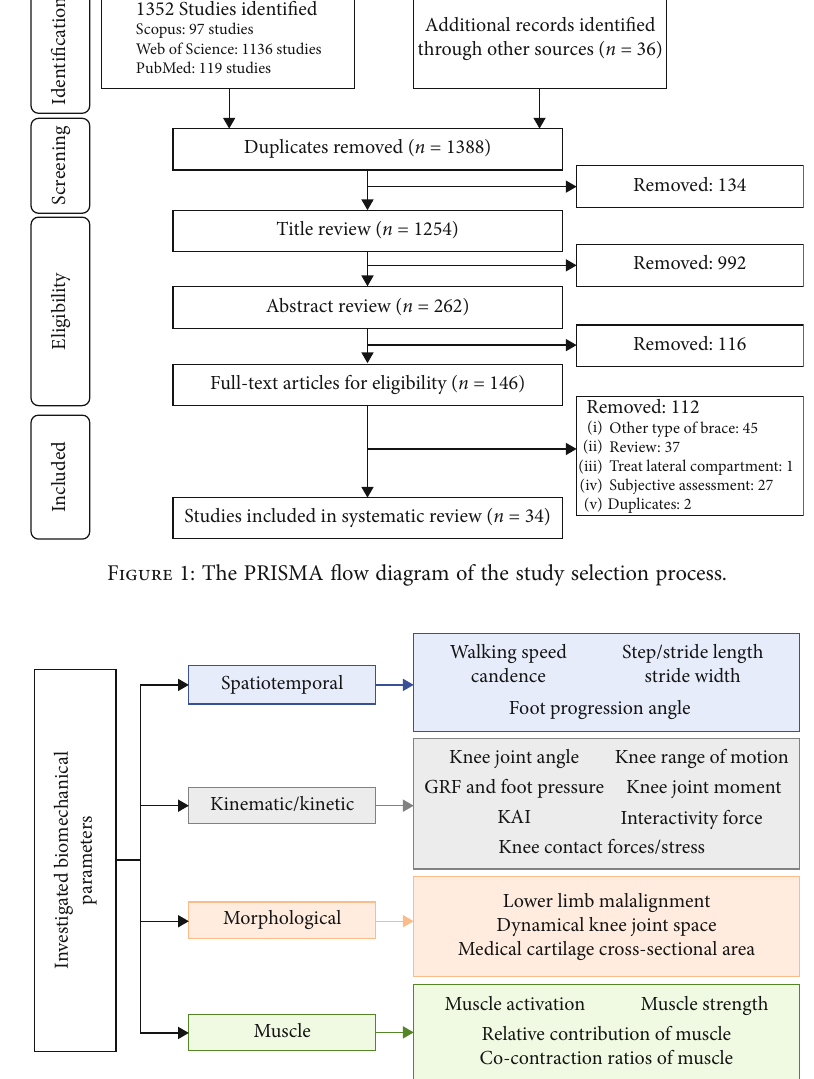
Figure 2: Tree diagram displaying the investigated biomechanical parameters. GRF: ground reaction force; KAI: knee adduction moment impulse.